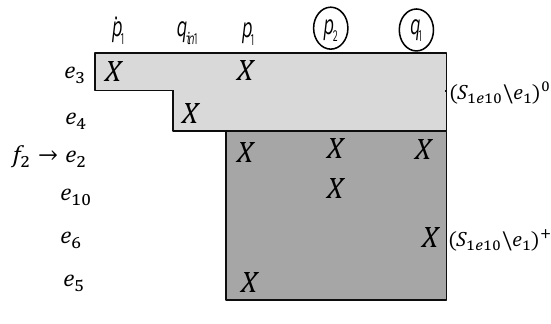
Figure 4. DM decomposition of S 1 e 10 \ e 1